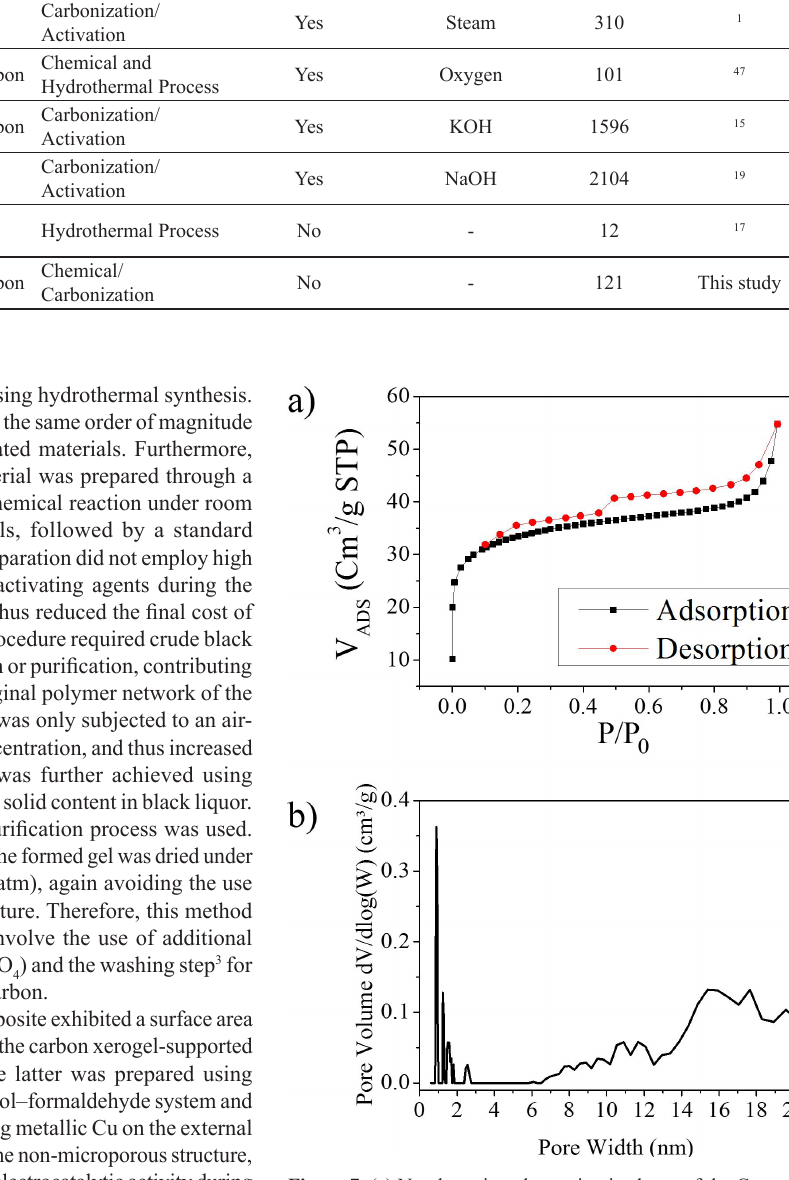
adsorption–desorption isotherm of the C matrix, Figure 7. (a) N 2 and (b) pore-size distribution estimated using the DFT